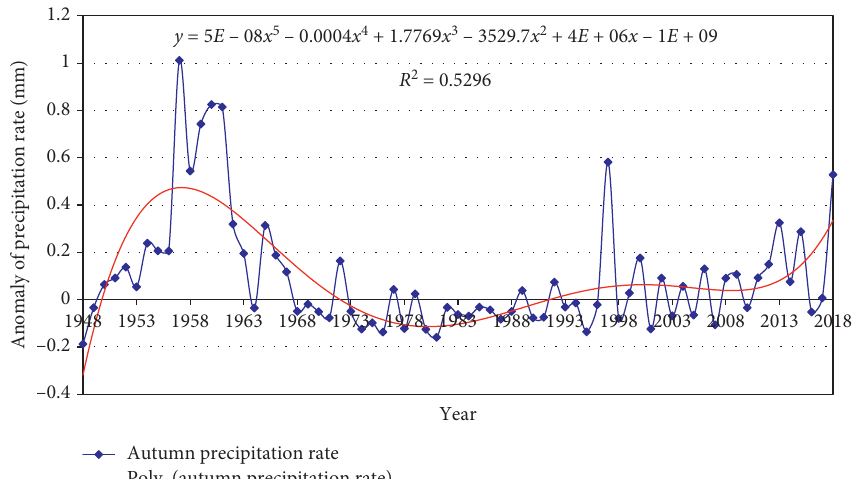
Figure 5: Time series of PR anomaly for PR (mm/day) and its polynomial trend over the Arabian Peninsula, including SA for the fall seasons throughout the period